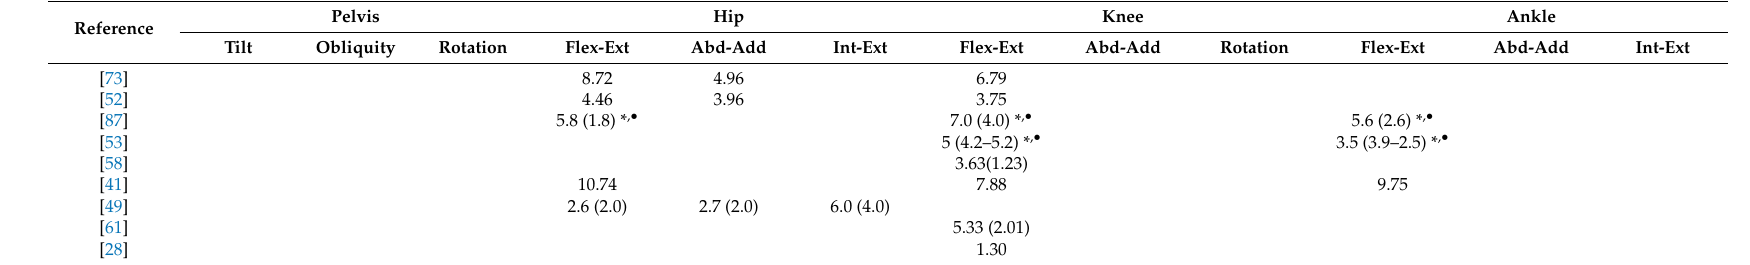
Table 5. RMSE for each study that uses it, Mean (standard